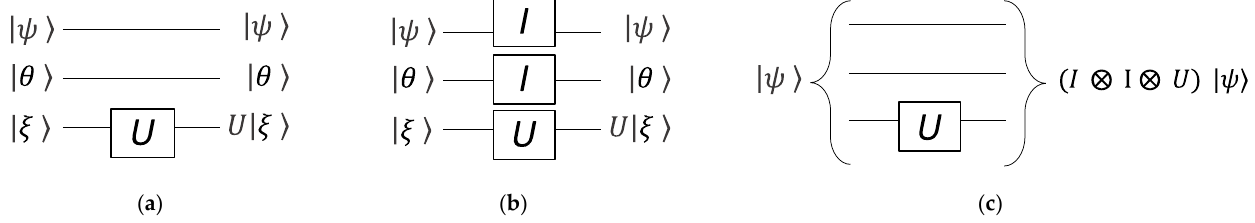
Figure 5. Module with a gate applied to a subset of qubits: ( a ) a single gate to a qubit; ( b ) the equivalence using identity gates; and ( c ) the situation when there is entanglement.